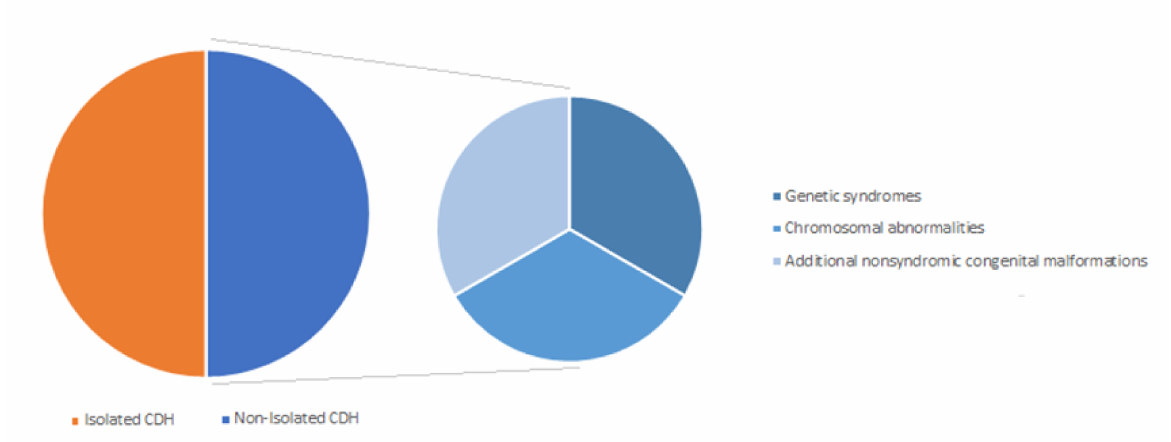
Figure 4. Classification of congenital diaphragmatic hernia